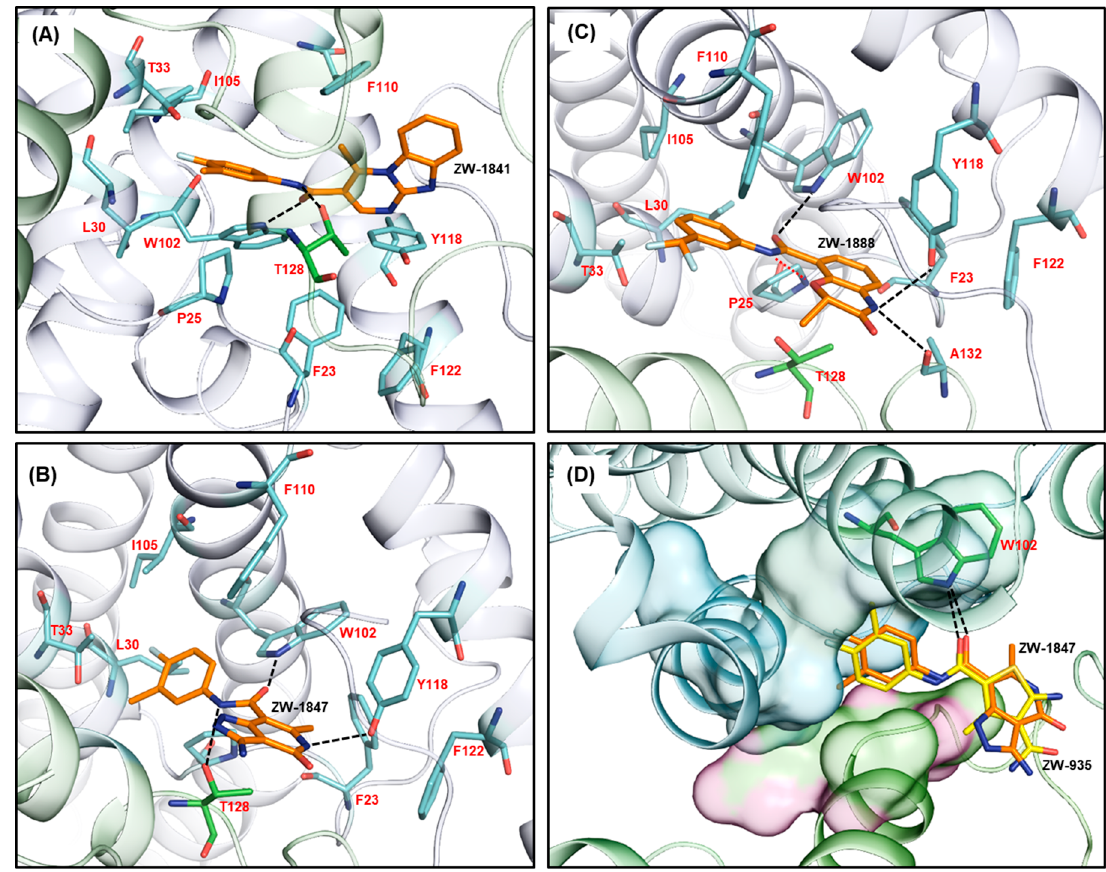
Figure 7. Predicted optimal binding modes of ( A ) ZW-1841, ( B ) ZW-1847, and ( C ) ZW-1888, and ( D ) the overlay of the best binding poses of ZW-935 and ZW-1847. Potent compounds identified in this study are shown in orange carbon skeleton and ZW-935 is shown in yellow carbon skeleton. The active site residues are shown as light blue and light green sticks. Important interactions are depicted as black dashed lines. Intramolecular H-bonding is shown as a red dotted line. Valency and hydrogen atoms are omitted for clarity. Molecular modeling was carried out using PDB ID: 5WRE.